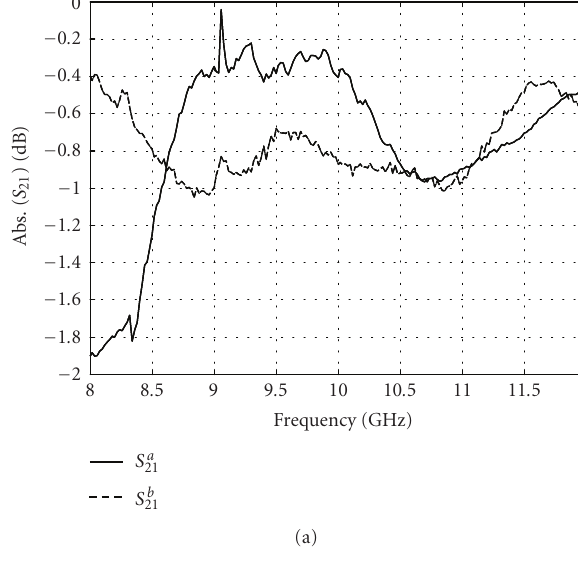
Figure 8: Sample diameters for air gap correction.